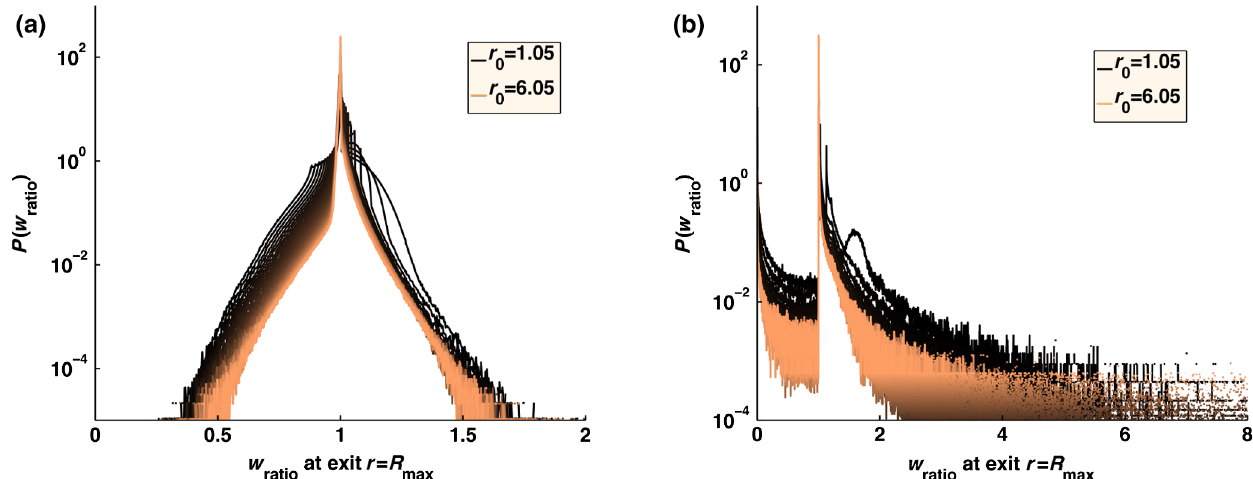
4. Distribution of exact to simulated trajectory probabilities on exiting the reaction zone for different initial separations r 0 , with each curve representing an increment of 0.1 nm in r 0 . These values reflect the degree of overlap between the exact and the simulated trajectories. If the reweighting-factor distributions are broad, the simulated trajectories will waste time on highly improbable trajectories, and miss out on some relevant trajectories, hence, undersampling in Eq. (19). (a) k a ¼ 10 . 0 nm 3 = μ s, D AB ¼ 20 nm 2 = μ s, Δ t ¼ 0 . 1 μ